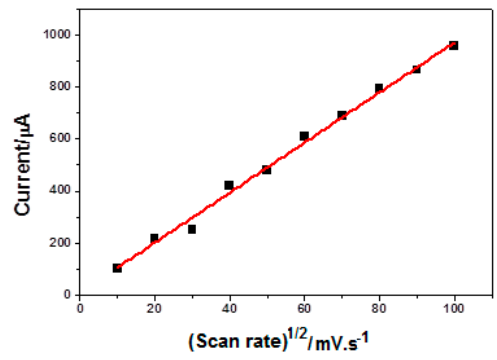
Figure 5. Randles–Sev č ik plot for the anodic Peak a of Figure 4.